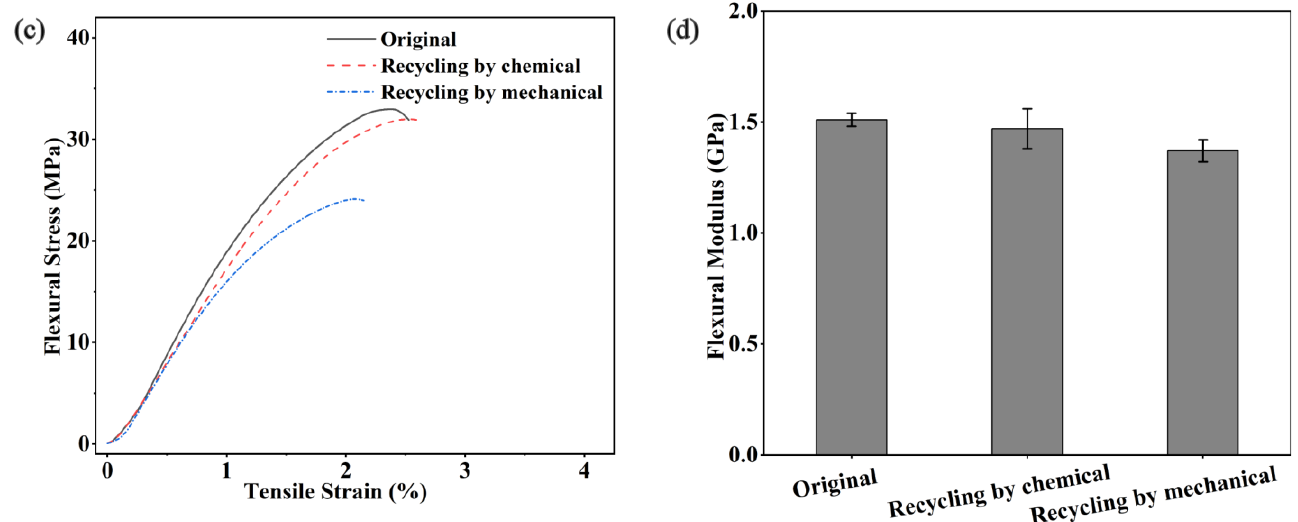
Figure 10. Mechanical properties of the original and recycled UWPU composites: ( a ) tensile stress – strain curves; ( b ) tensile modulus; ( c ) three-point flexural stress – strain curves; ( d ) flexural modulus.